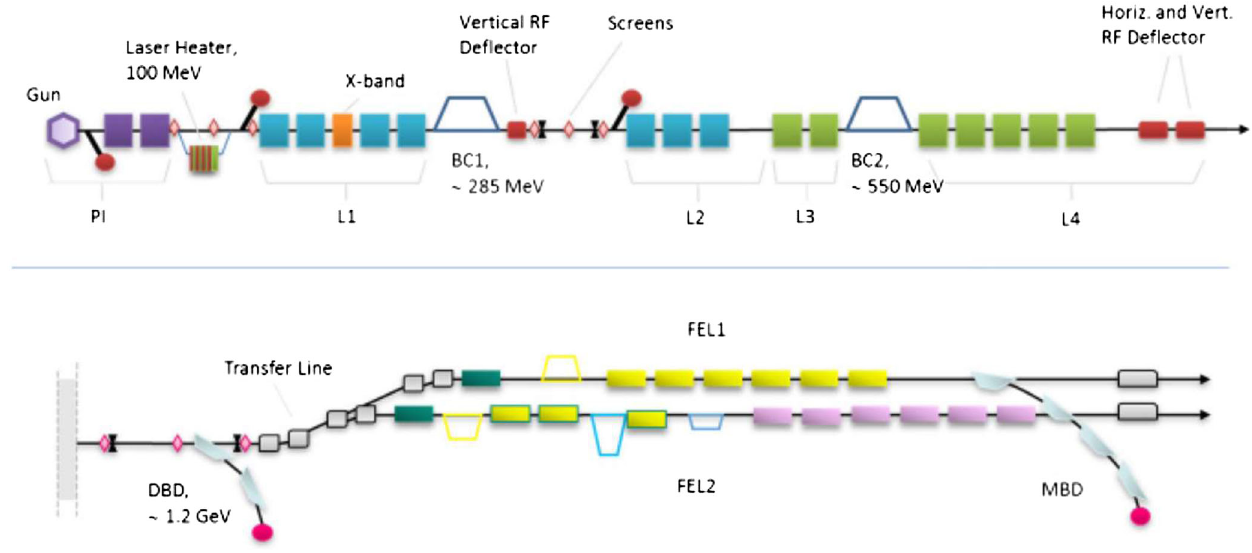
FIG. 1. Sketch of the FERMI S-band accelerator and FEL lines (not to